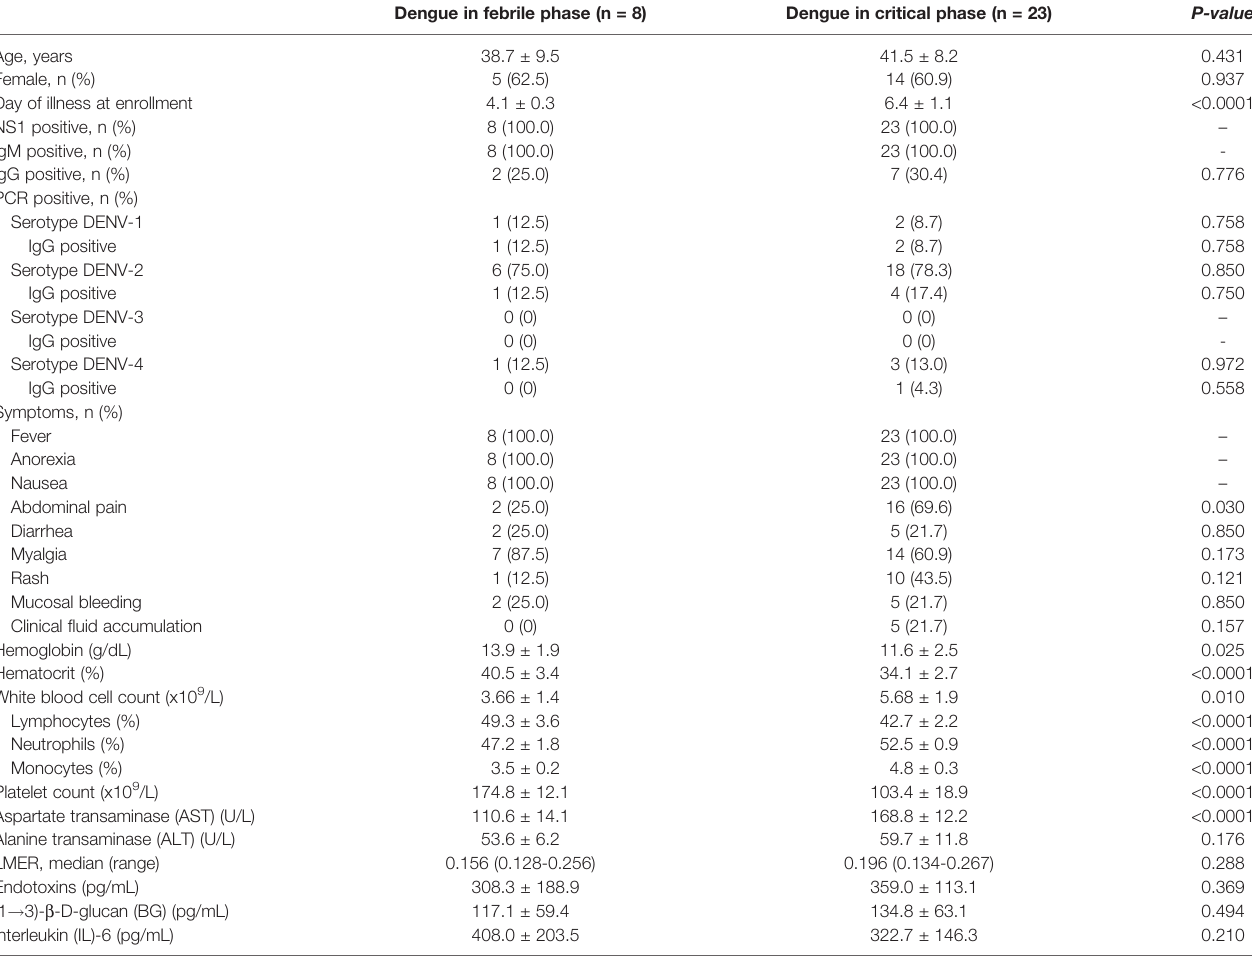
TABLE 1 | Differences in baseline characteristics and clinical parameters between dengue patients in febrile phase and critical